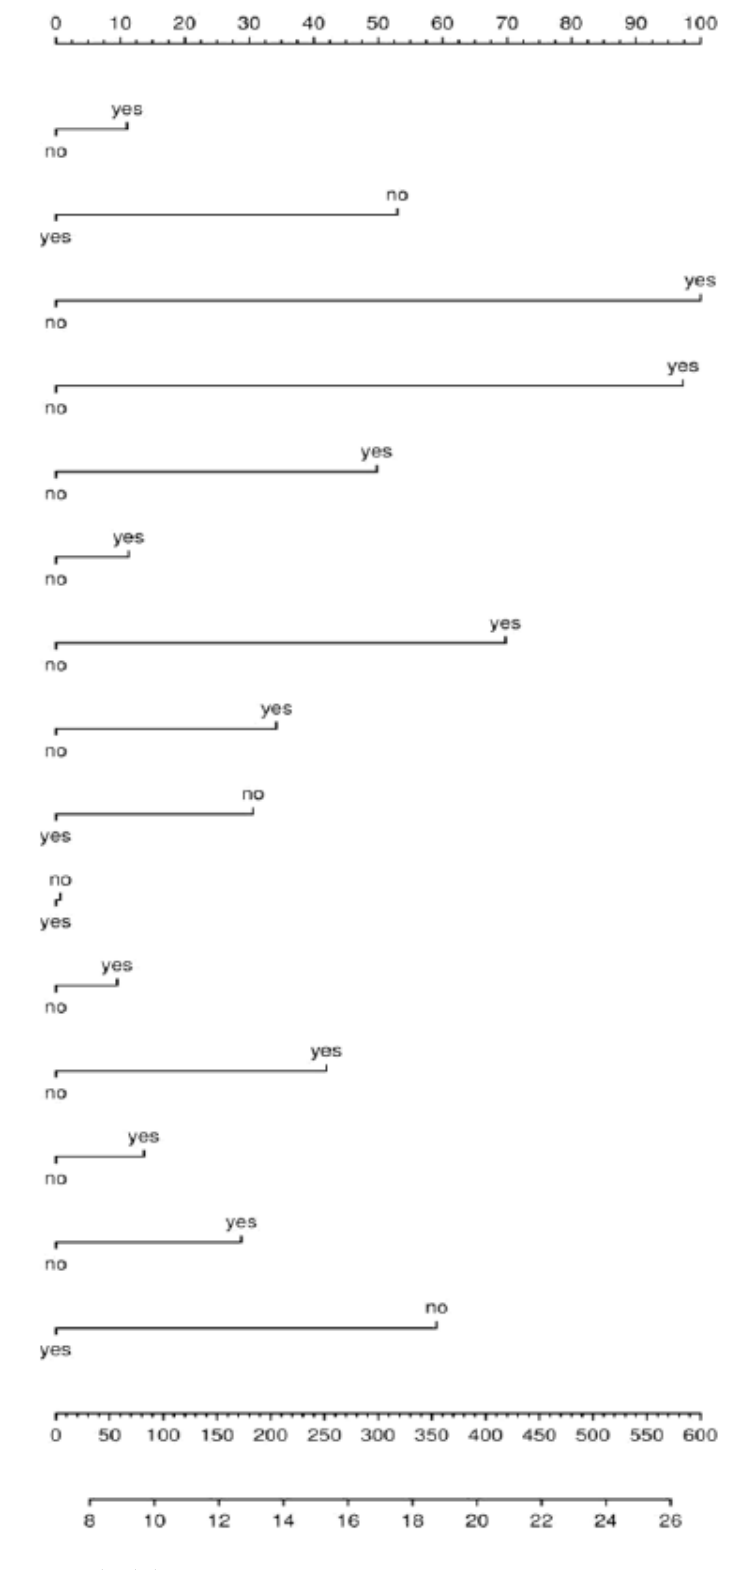
Figure 5. Nomogram ADL disability score at T5. Figure A5. Nomogram ADL disability score at